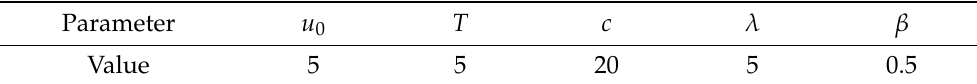
Table 1. Constants used in the numerical experiments: T > 0 is the (finite) time horizon, c is the premium rate, λ is the claim intensity, 1/ β is the mean claim size and u 0 is the largest initial capital for which we wish to approximate the probability of ruin in finite